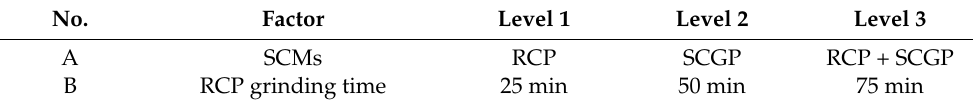
Table 2. Factors and levels of the experimental design.